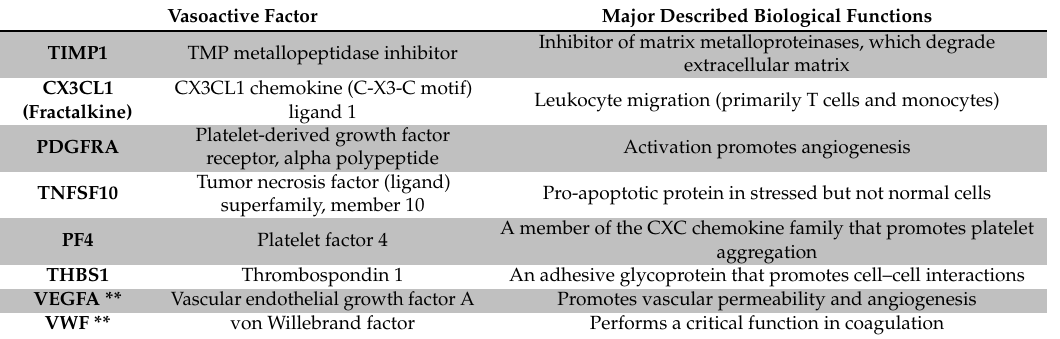
Table 2. Vascular functions of products with decreased expression in HuMEC cells in response to DENV-activated